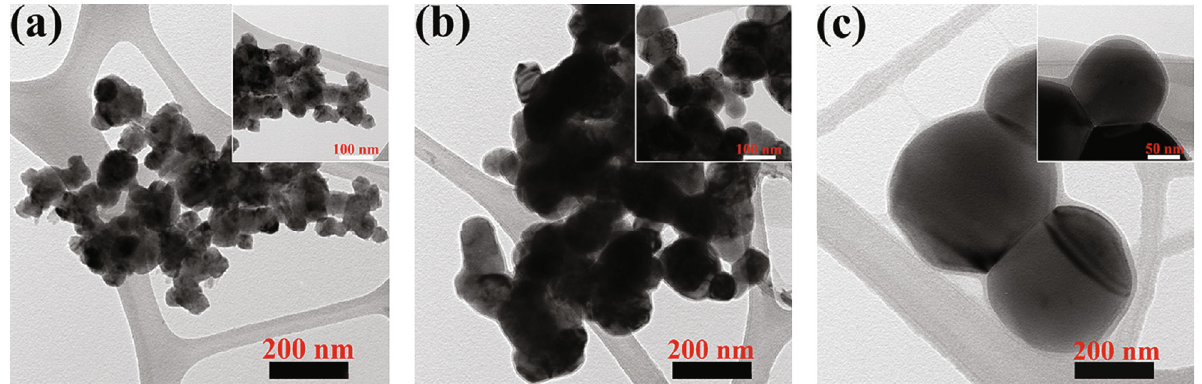
Figure 5: TEM images of (a) the neat VO